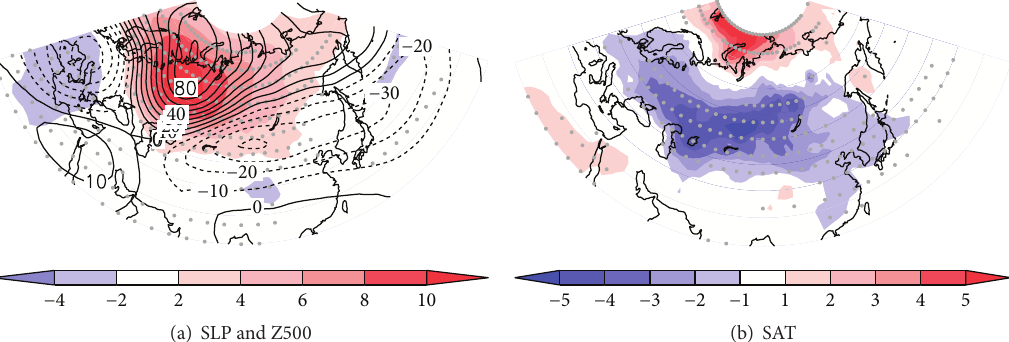
Figure 8: Same as Figure 6 but for SLP and Z500 in ((a) the units are hPa for SLP, gpm for Z500) and SAT in ((b) unit: K) between high and low ACI years ( ± 0.5 SD). The dotted areas indicate significant difference exceeding 0.05 for the two-tailed Student’s 𝑡 -test.